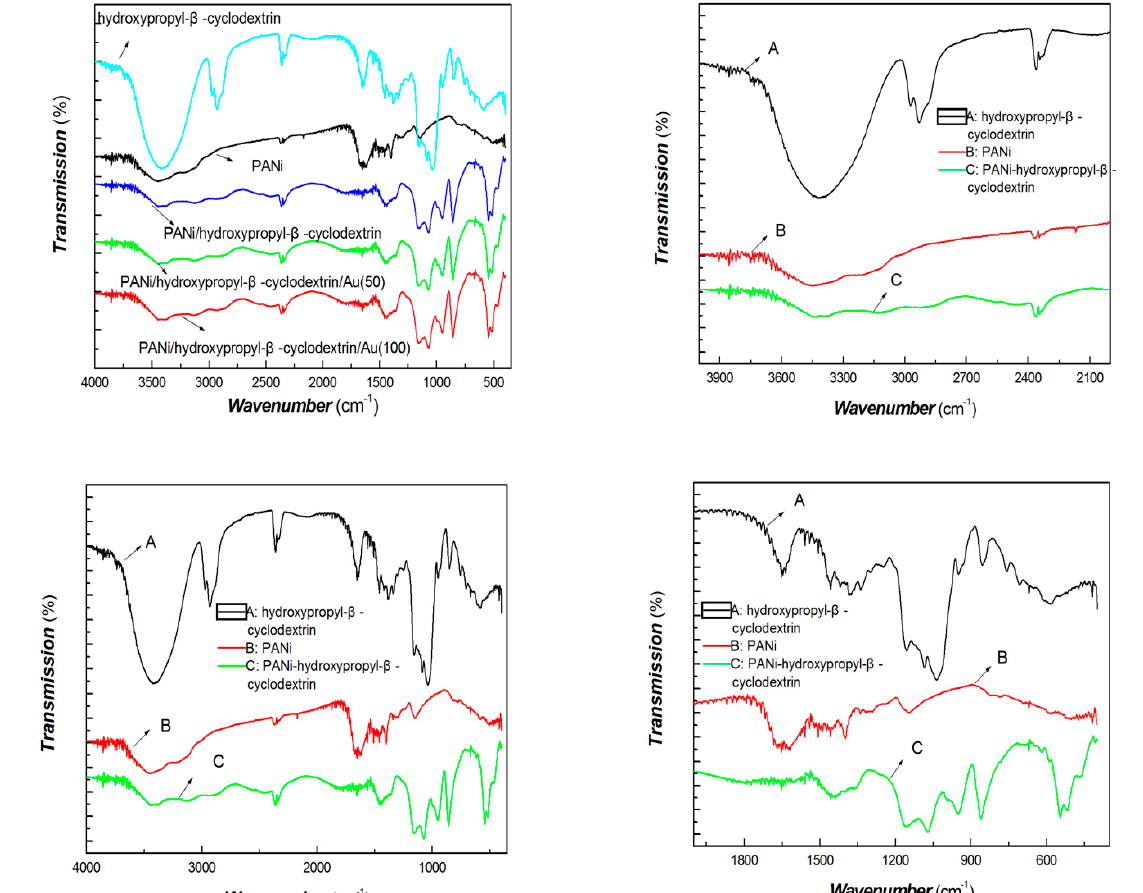
Figure 6. FTIR of a series of Au/PANi nanocomposites functionalized with beta-cyclodextrin, and a local enlargement.